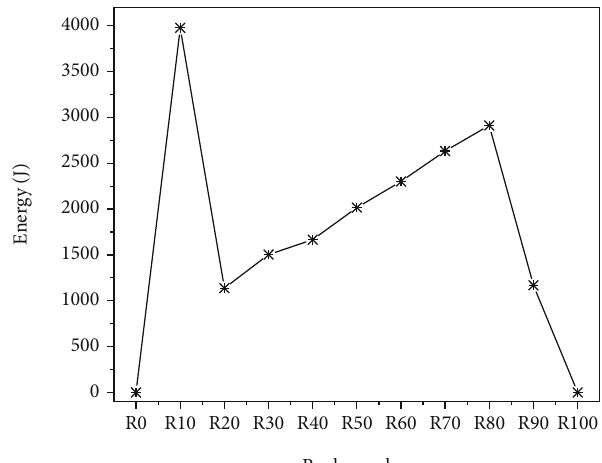
Figure 21: Pallet energy absorption density corresponding to di ff erent CRVs.